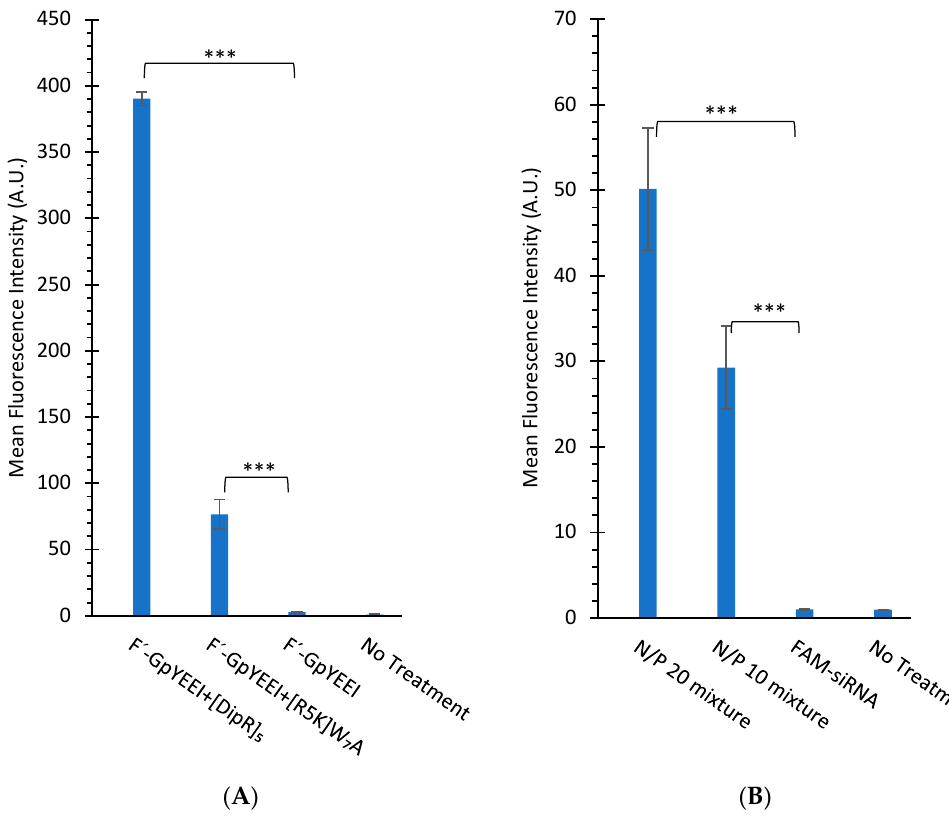
Figure 9. ( A ) Cellular uptake of F’-GpYEEI (2 µM) in the presence of [DipR] 5 or [R 5 K]W ₇ A (10 µM) in CCRF-CEM cells after 3 h incubation. ( B ) The cellular uptake of F’-siRNA (36 nM) in the presence of [DipR] 5 at different N/P ratios in MDA-MB-231 cells after 24 h incubation. Results are mean ± SD (n = 3) (*** p < 0.001).